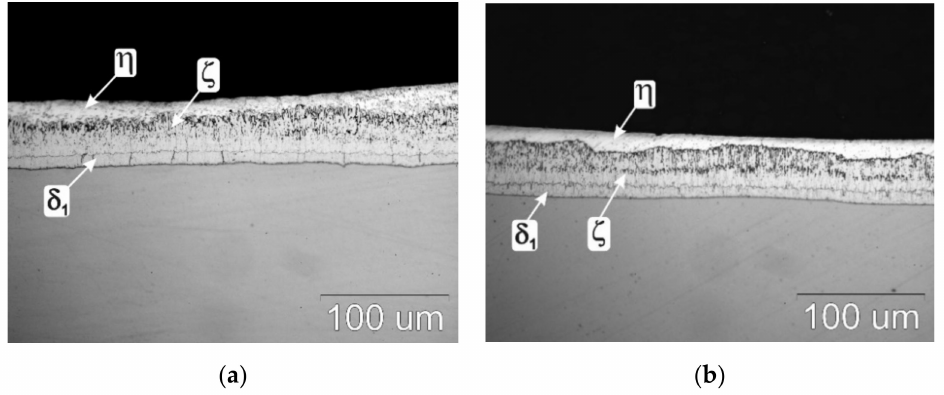
Figure 2. The outlook of coatings cross-section, made in: ( a ) Zn-AlNiBiSn, ( b ) Zn-AlNi